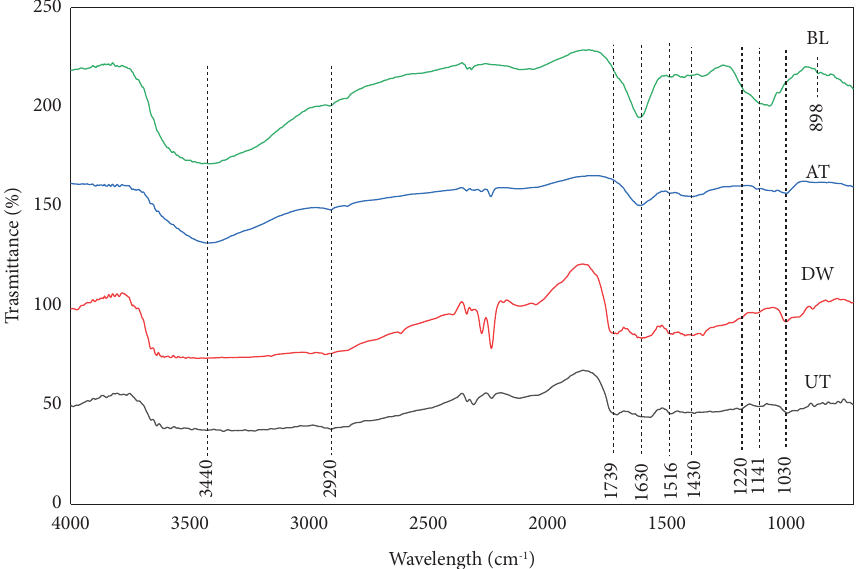
Figure 4: Infrared spectra of UT, DW, AT, and BL samples.